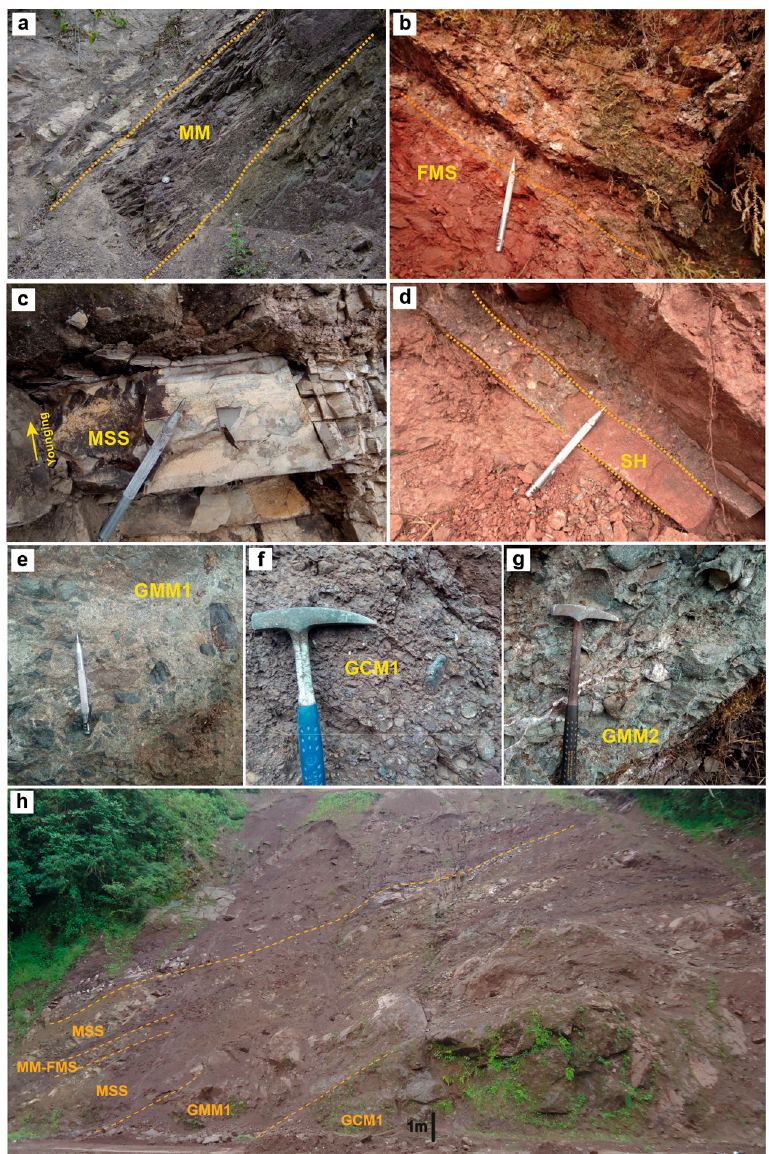
Figure 7. Photographs of representative lithofacies of the Silante Formation. ( a ) Lithofacies MM, mudstones and siltstone;s ( b ) lithofacies FMS, structureless sandstones; ( c ) lithofacies MSS, massive sandstone; ( d ) lithofacies SH, matrix supported conglomerates; ( e ) lithofacies GMM1, massive matrix supported conglomerates; ( f ) lithofacies GCM1, massive clast supported conglomerates; ( g ) lithofacies GMM2, matrix supported conglomerates; ( h ) representative outcrop of the Silante Formation and the spatial distribution of the lithofacies.